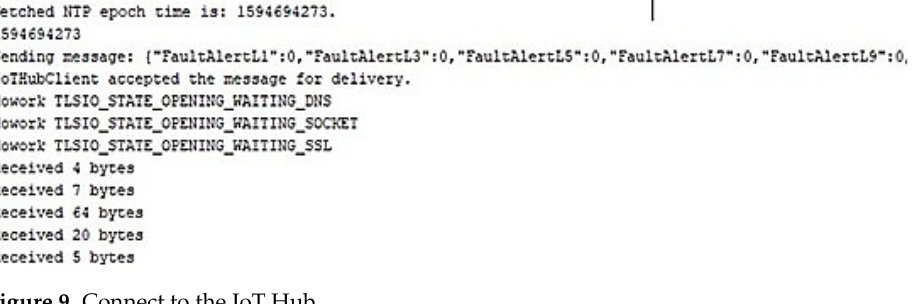
Figure 9. Connect to the IoT Hub.